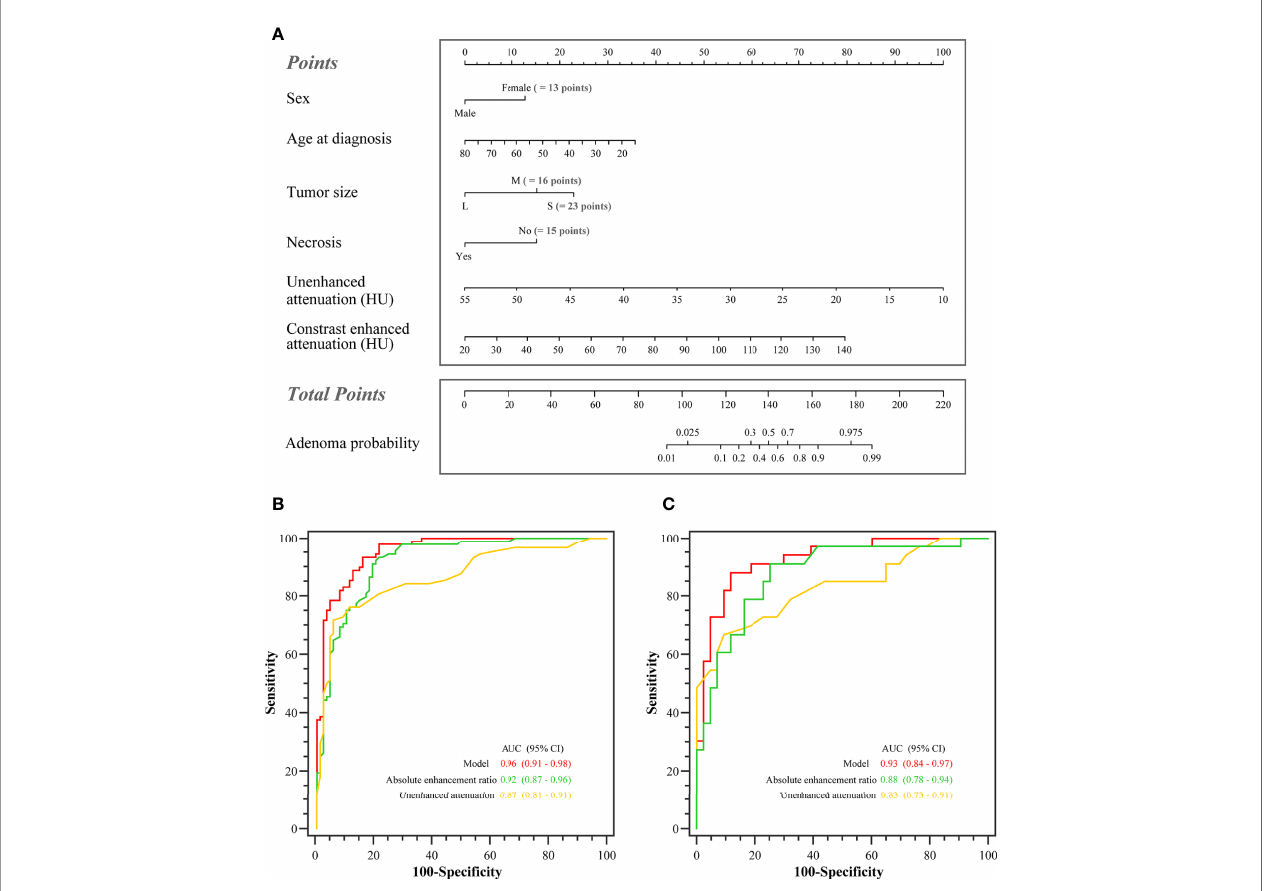
FIGURE 2 | The nomogram and the receiver operating characteristic (ROC) curves in the training set and the internal validation set. (A) Nomogram of lipid-poor adrenal adenoma prediction based on clinical-image model. Added up the scores of each variable to get the total score. Based on it, the probability of lipid-poor adrenal adenoma was showed by projecting the score to the risk axis. Online tool is available at https://zhanghuangqi.shinyapps.io/dynnomapp/. (B) The ROC curves for differentiating lipid- poor adenomas and nonadenomas in the training set. The highest area under the curve was obtained with the combined model (0.96 [95% CI: 0.91, 0.98]), followed by absolute enhancement rate (0.92 [95% CI: 0.87, 0.96]), and unenhanced attenuation (0.87 [95% CI: 0.81, 0.91]). (C) The combined model displayed the best diagnostic performance for prediction of lipid-poor adenomas in the internal validation set (AUC, 0.93 [95% CI: 0.84,